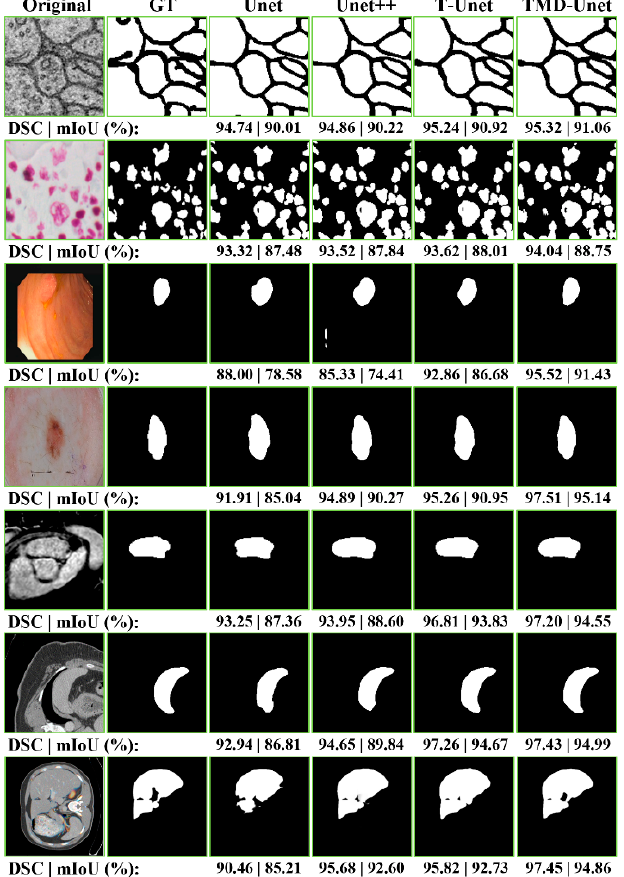
Figure 6. The examples of the segmentation results on the testing images of the dataset. The first column shows the original images while the second column indicates the ground truth (GT). From the third to the seventh column are the accomplished results by Unet, Unet++, T-Unet, and TMD-Unet, respectively. The segmented applications are listed in top-to-bottom rows: EM, nuclei, polyp, left atrium, skin lesion, spleen, and liver, respectively.